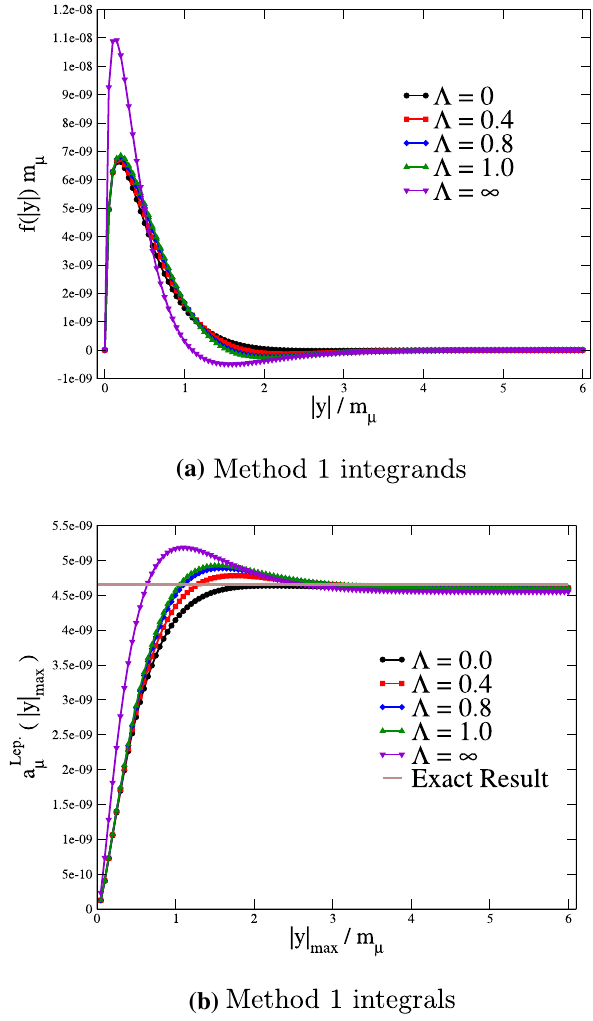
Fig. 17 Correspondence between connected (method 2) and discon- nected diagrams (left) and PS-meson exchange channels (right) in posi- tion space of the four-point functions described in the text. The top-left figure should be understood as containing quark flow in both orienta- tions, representing exactly all the relevent diagrams for method 2. Note that the charge factors are not included here